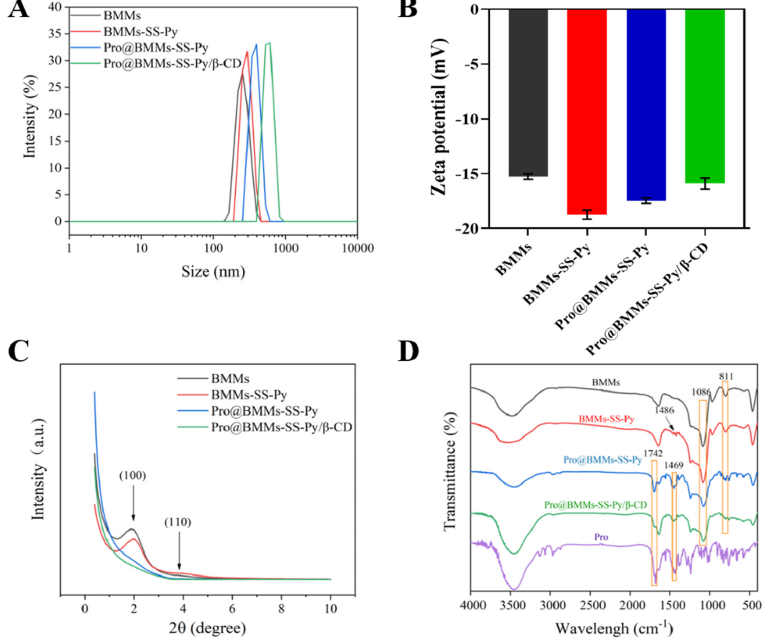
Figure 3. ( A ) Particle size distributions ( B ) , zeta potentials, ( C ) XRPD patterns, and ( D ) FTIR